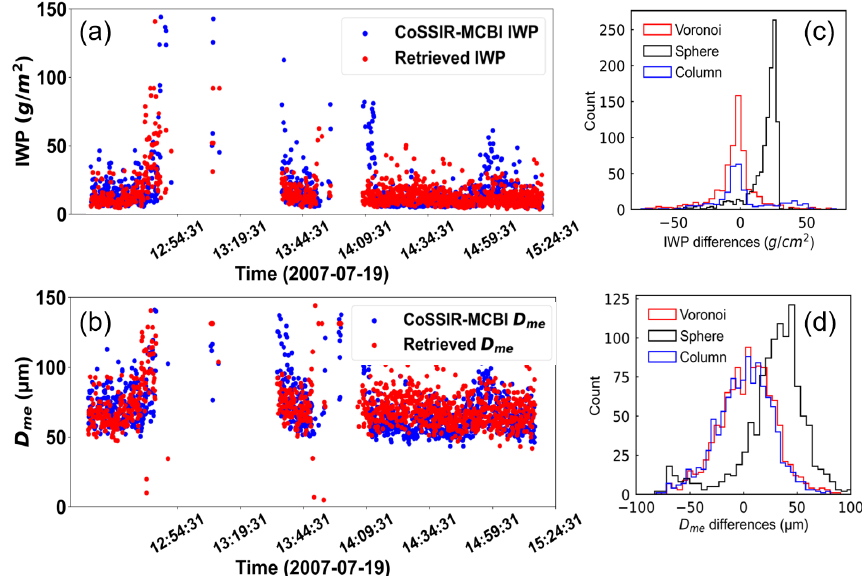
Figure 11. The scattered red dots are the retrieved (a) IWP and (b) D me (bottom row) validated by the results from the CoSSIR-MCBI algorithm (blue scattered dots). The joint histogram of differences in the retrieved (c) IWP and (d) D me between the Voronoi, sphere, and column schemes and the CoSSIR-MCBI results, respectively.